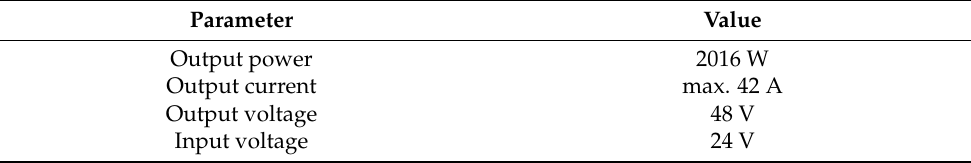
Table 4. Parameters of the DC/DC